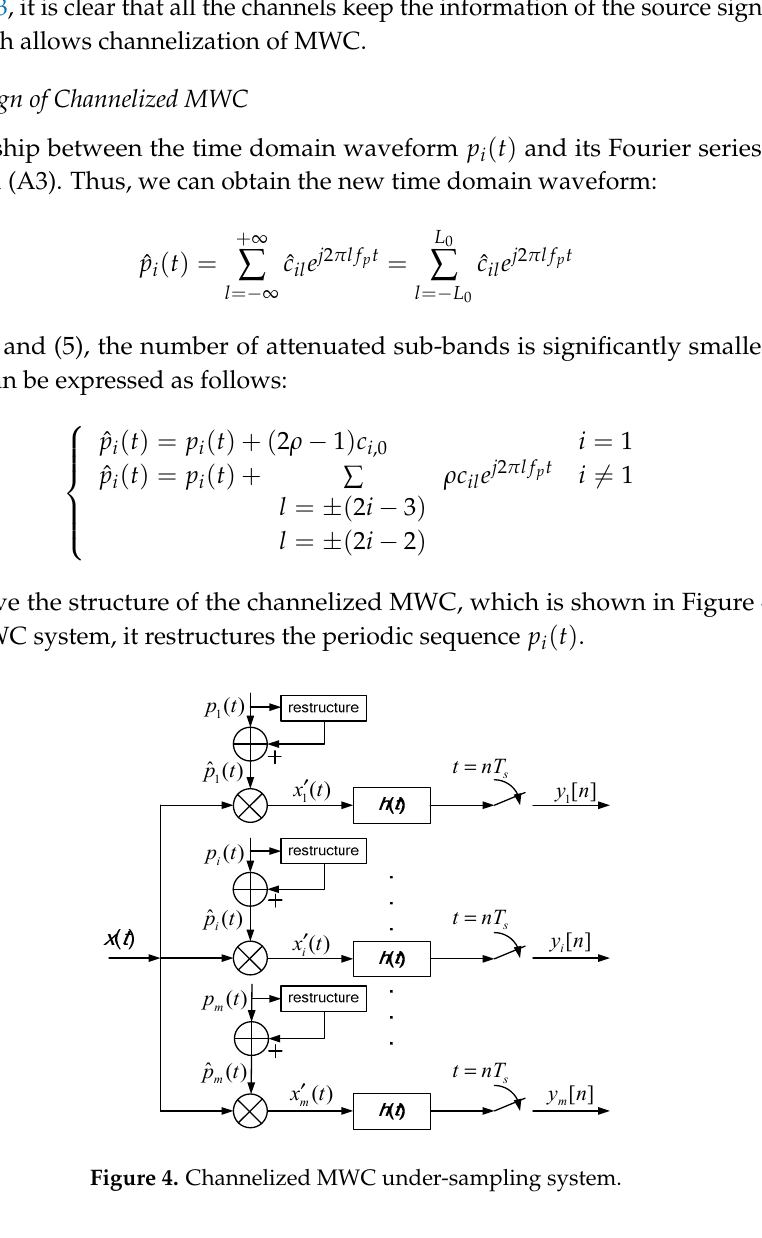
Figure 3. The relationship between